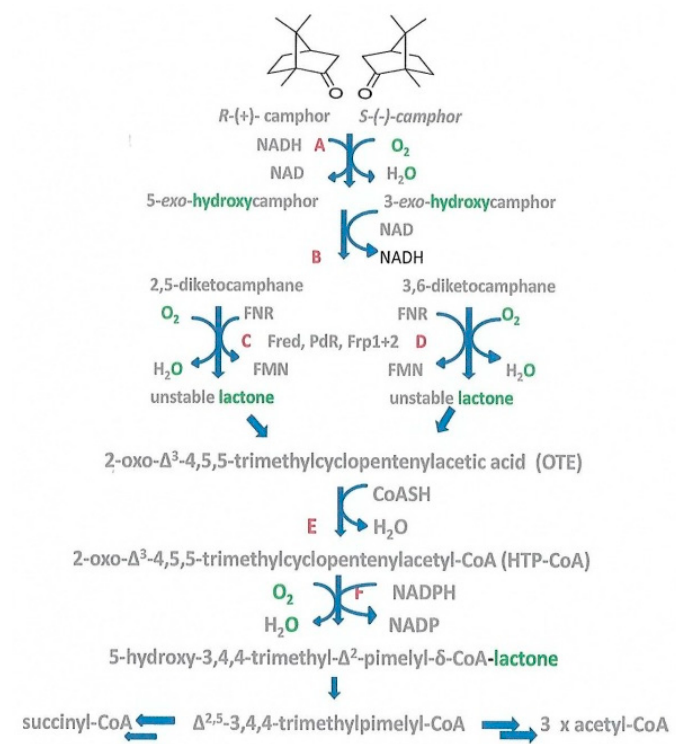
Figure 1. Pathway of (+)- and ( − )-camphor degradation in Pseudomonas putida ATCC 17453. A, cytochrome P450 monooxygenase ( camCAB ); B, exo -hydroxycamphor dehydrogenase ( camD ); C, 2,5-diketocamphane 1,2-monooxygenase ( camE 25-1 + camE 25-2 ); D, 3,6-diketocamphane 1,6-monooxygenase ( camE 36 ); E, 2-oxo- Δ 3 -4,5,5-trimethylcyclopentenylacetyl-CoA synthetase ( camF1 + F2 ); F, 2-oxo- Δ 3 -4,5,5-trimethylcyclopentenylacetyl-CoA monooxygenase ( camG ); FNR, reduced flavin mononucleotide; Fred, 36 kDa chromosome-coded flavin reductase; PdR, putidaredoxin reductase subunit of cytochrome P450 monooxygenase ( camA ); Frp1 + 2, chromosome-coded ferric reductases. Diatomic oxygen molecules participating in the four monooxygenase-catalysed steps are shown in green, as in each case are the fates of each component oxygen atom. Adapted from Figure 1 [20],